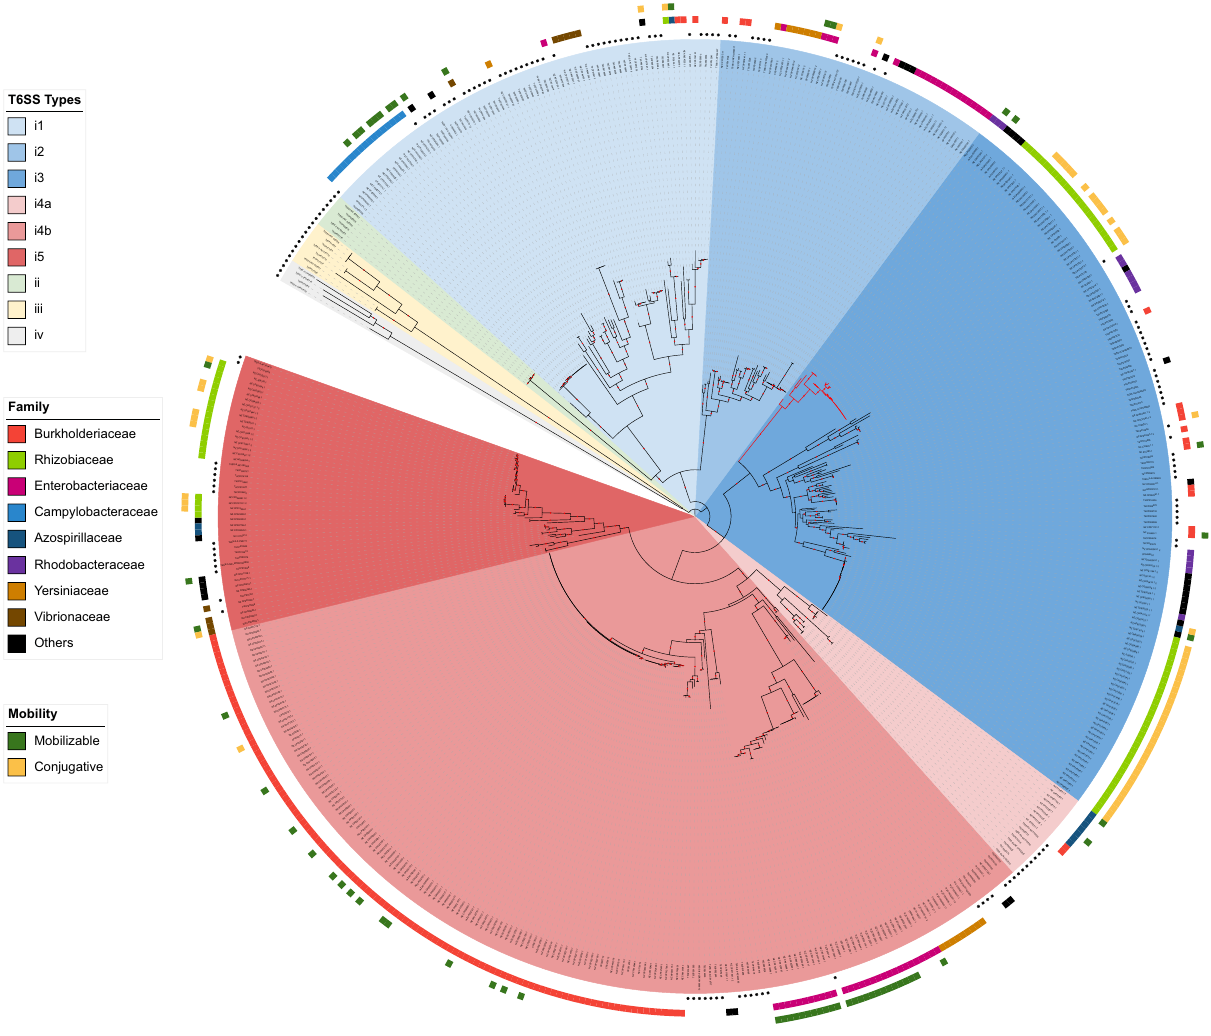
Figure 2. Phylogenetic relationship of plasmid T6SS based on TssB core component protein and maximum likelihood method. The sequences are divided into four types (T6SS i-iv ) and six subtypes (i1, i2, i3, i4a, i4b, and i5) by colored backgrounds. The chromosomal reference sequences have black circles adjacent to their labels. The red branch represents sequences assigned to the i3 subtype, but which are not grouped with the i3 reference sequences. The colored blocks closest to the tree represent the bacterial families from which the sequences were obtained. The predicted mobility of the plasmids harboring the T6SS gene clusters is indicated by the outer colored blocks. Bootstrap values above 70 are shown as red circles in the middle of the